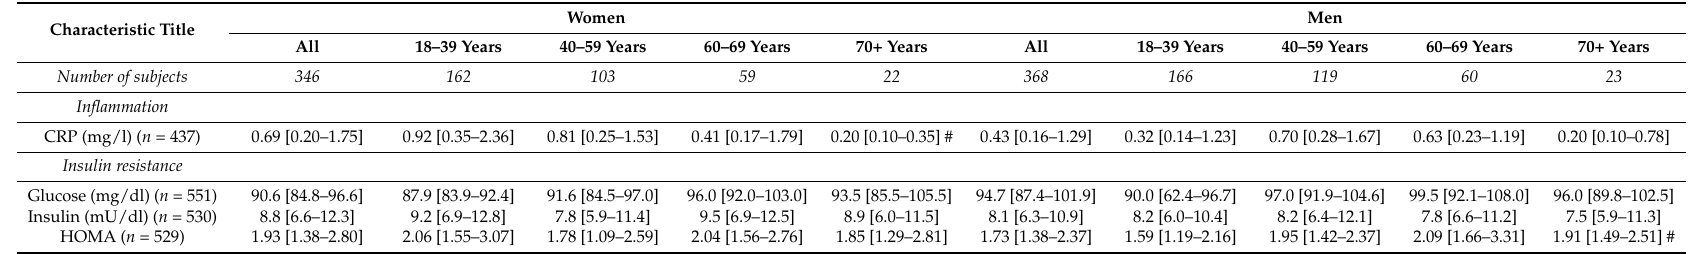
Table 3. Characteristics of metabolic risk factors of the study population ( n =